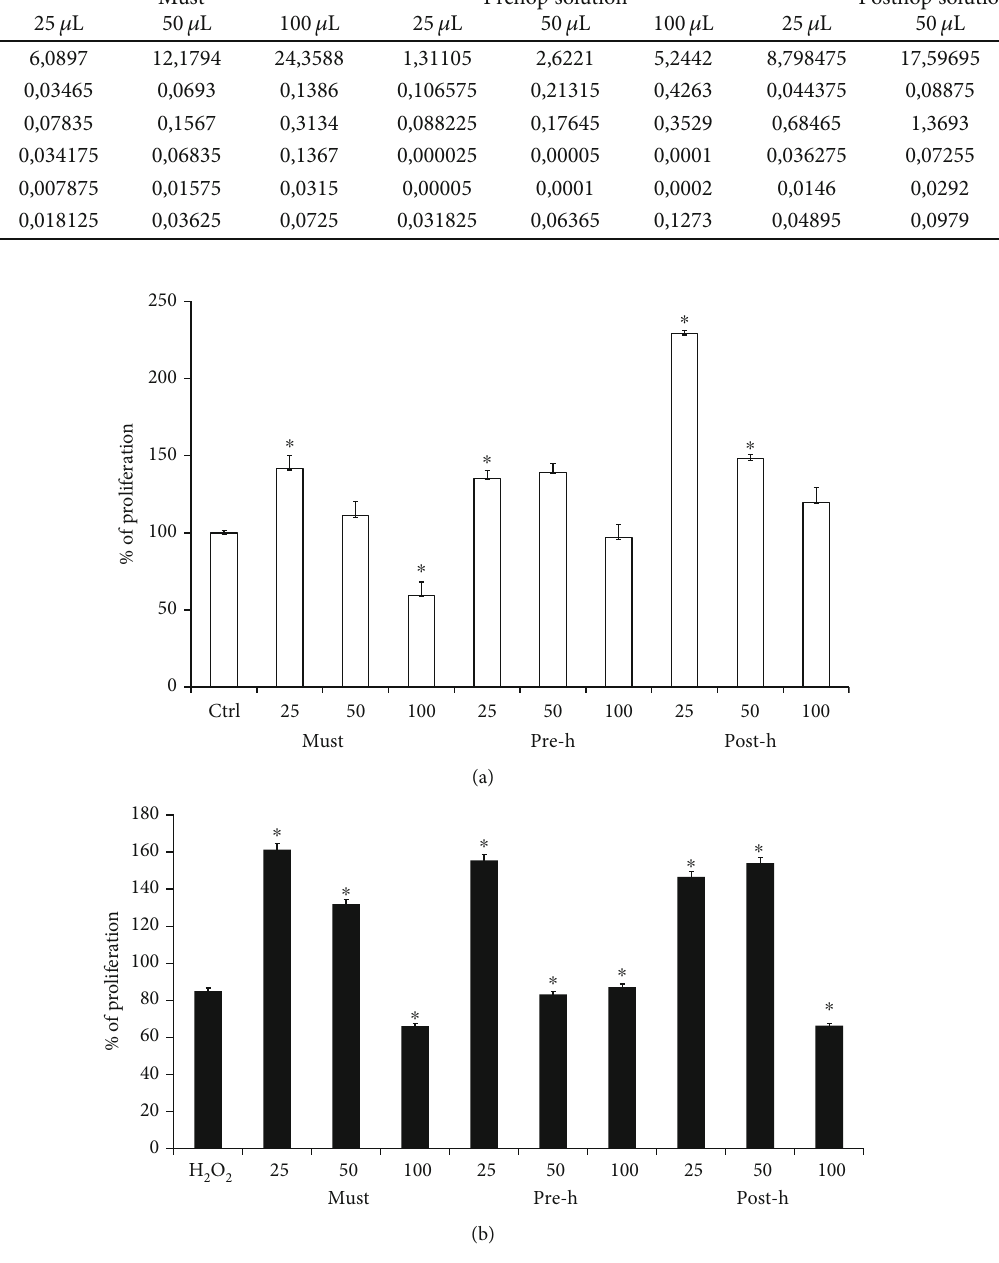
Figure 2: E ff ect of beer fractions on D-dSCs. D-dSCs viability was determined by MTT assay. (a) Cells treated with beer fractions solution: must (must), prehopping solution (pre-h), and posthopping solution (post-h). (b) Cells pretreated with beer fractions as above and then stimulated with H O 180 μ M for 30 ′ . The histogram shows % of cell proliferation normalized to untreated control cells. The quantity of 2 2 single treatment is expressed in μ L. The statistical analysis derived from at least 3 experiments in triplicate (Student ’ s t -test) is shown ∗ p < 0 : 05 compared to the untreated